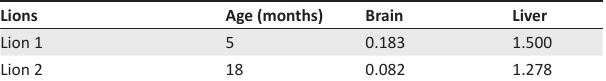
TABLE 1: Brain and tissue doramectin concentrations (mg/kg) in two lions with doramectin toxicity. Lions Age